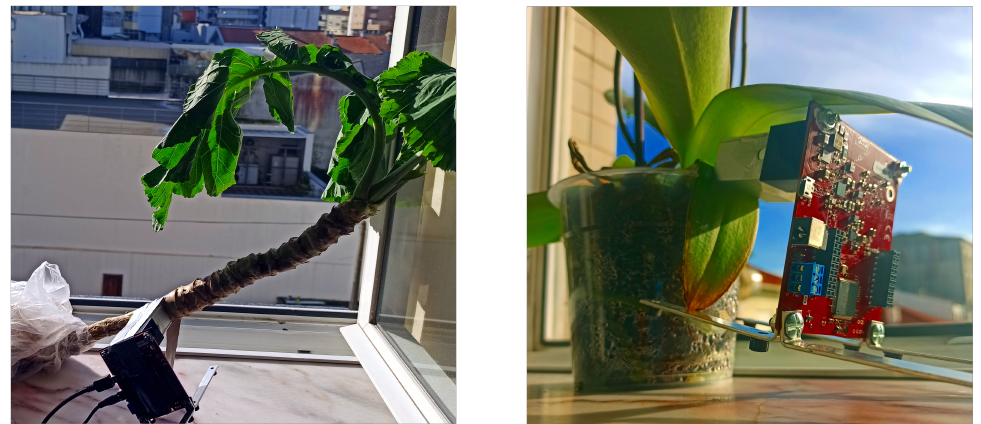
Figure 8. Radar setup to performs tests with a kale’s stem ( left ) and an orchid leaf ( right ).